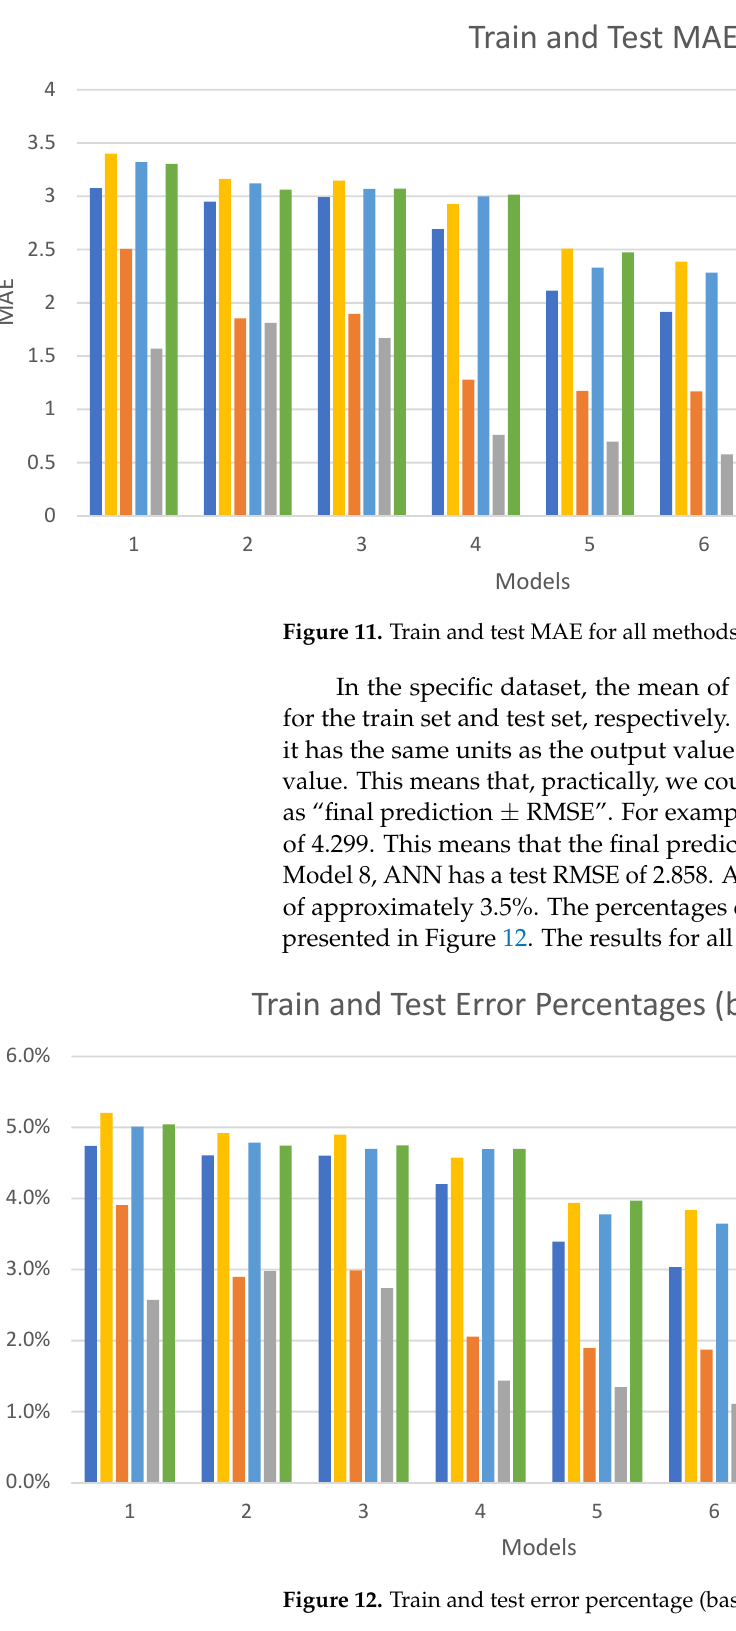
Figure 10. Train and test RMSE for all methods.